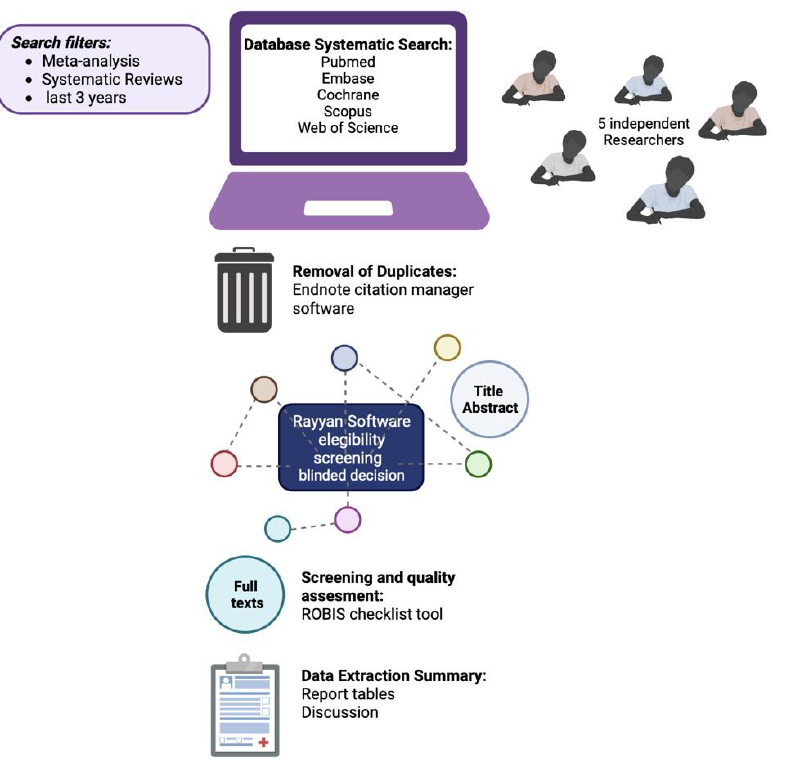
Figure 1. Picture chart of the protocol for the umbrella review steps. Created at 2022 Biorender, online software, Toronto, Canada.